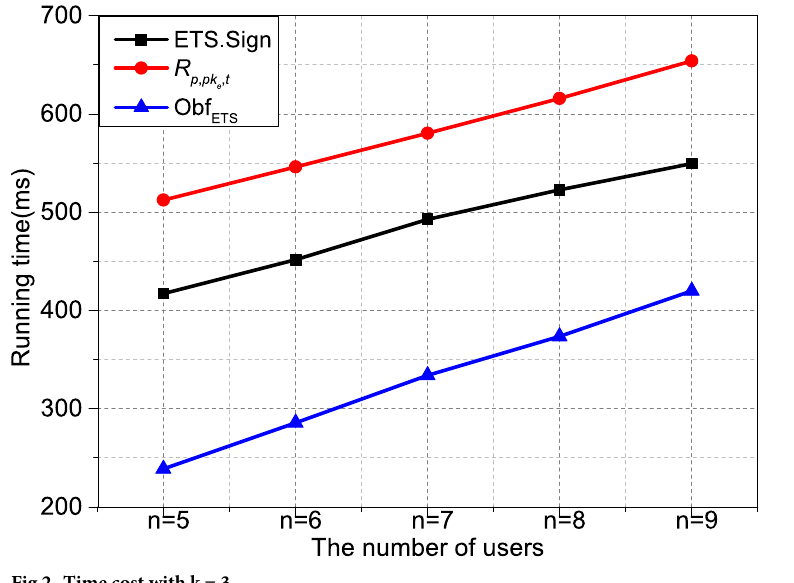
Fig 2. Time cost with k =